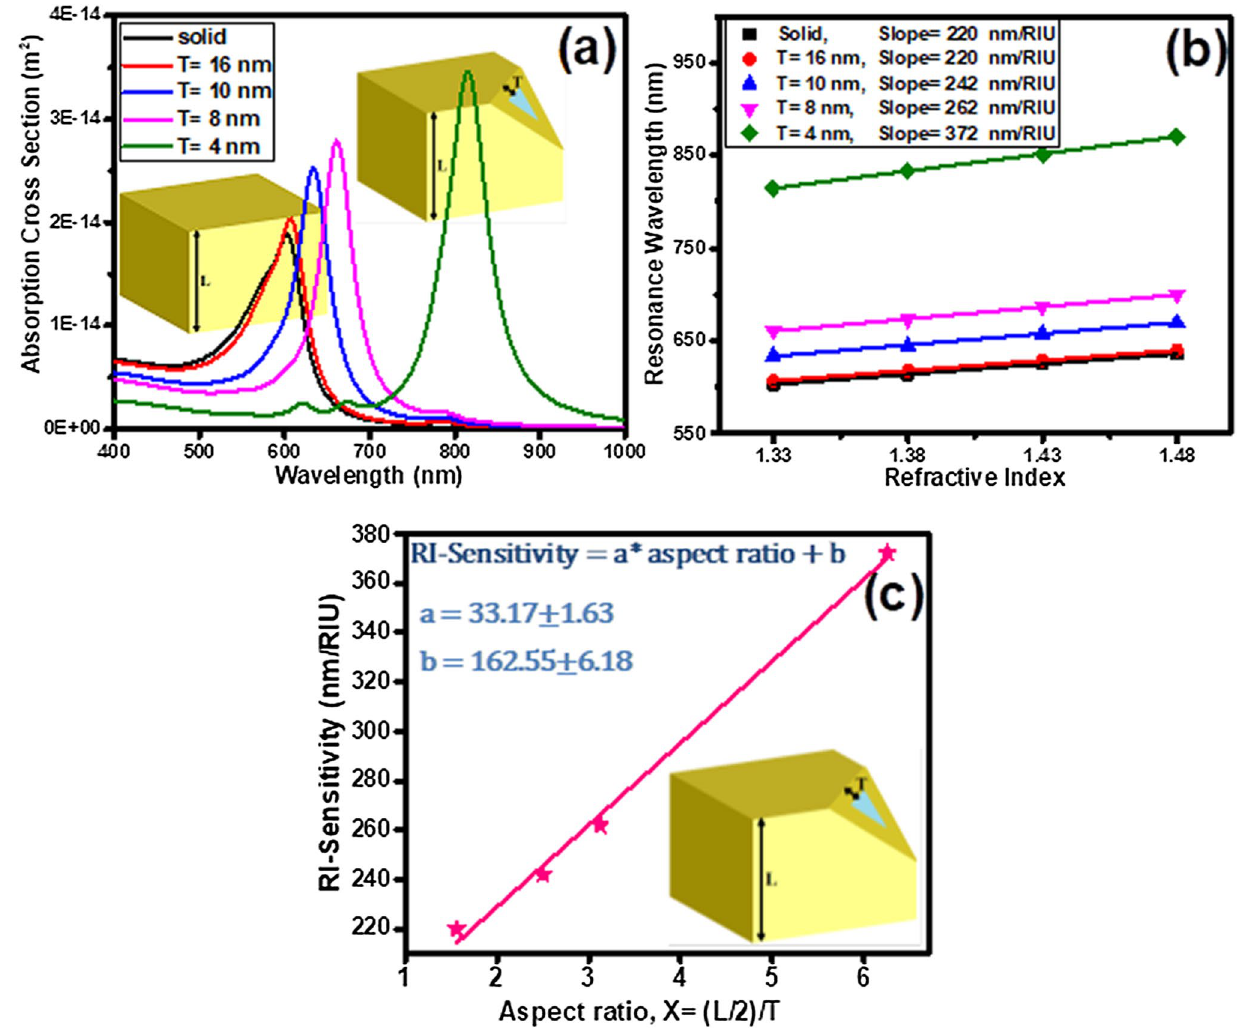
Figure 1. ( a ) Absorption spectra of silica@gold core–shell nanoparticles with various shell thickness, T (n = 1.33). ( b ) The LSPR shift of cubic nanoshells with various shell thickness (T) versus different refractive index of surrounding medium. ( c ) The RI-Sensitivity shift of cubic nanoshells versus different aspect ratio, X (Half the total size (L/2) -to- shell thickness (T)) ratio). A fit to the data with linear equation S = a × X + b. Browser-based version of SketchUp, https ://app.sketc hup.com, and Origin 2020 version, https ://www.origi nlab. com, have been used for drawing images and making figures,